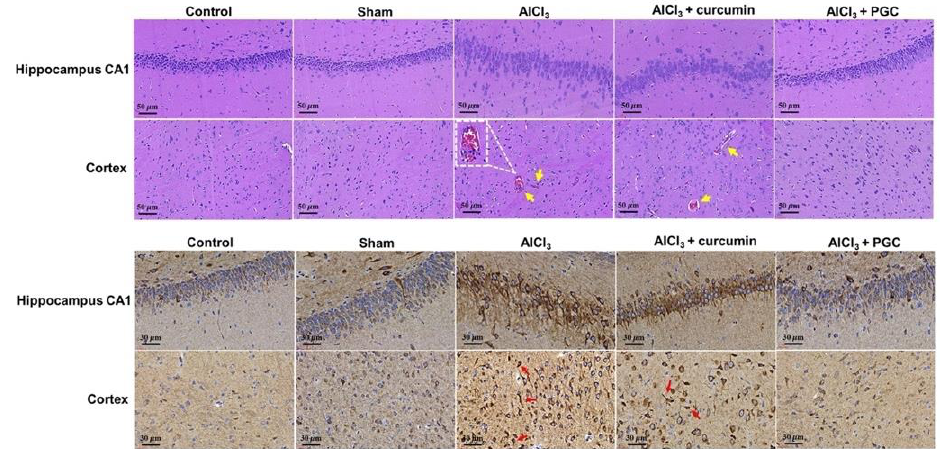
Figure 8. Histological staining. Hematoxylin and eosin (H&E) staining of hippocampal CA1 and cortex regions of the tested rats. Brain sections from rats treated with AlCl 3 show that pyramidal cells in the hippocampal CA1 region exhibited more severe morphological changes. BACE1 revealed plaque-like staining in the brains of AD rats by immunohistochemistry. Scale bars: 50 and 30 μm.